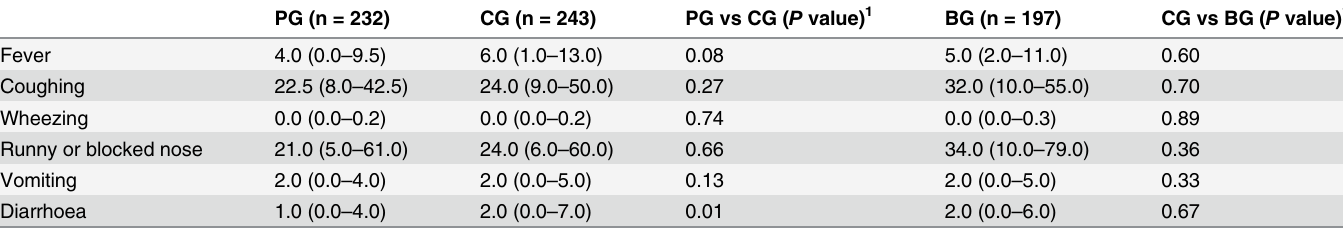
Table 5. Duration of illness episodes in days from third to fifth birthday, median and 25 – 75 percentiles PG (n = 232) CG (n = 243)